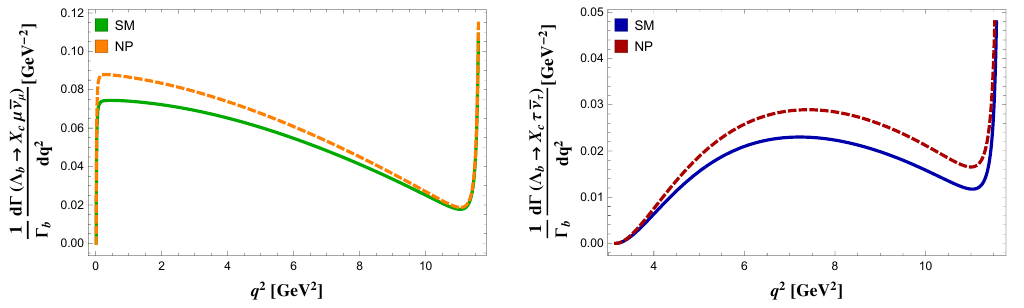
Figure 4 . Decay distribution in the dilepton invariant mass q 2 for (cid:3) b ! X c ‘ (cid:22) (cid:23) ‘ , with ‘ = (cid:22) (left) and ‘ = (cid:28) (right). The solid line is the SM result, the dashed line the result for NP at the benchmark